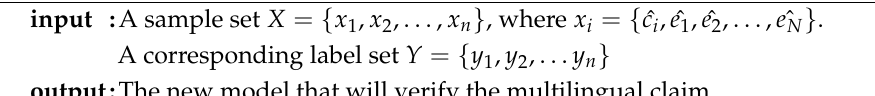
Algorithm 1: The process of training